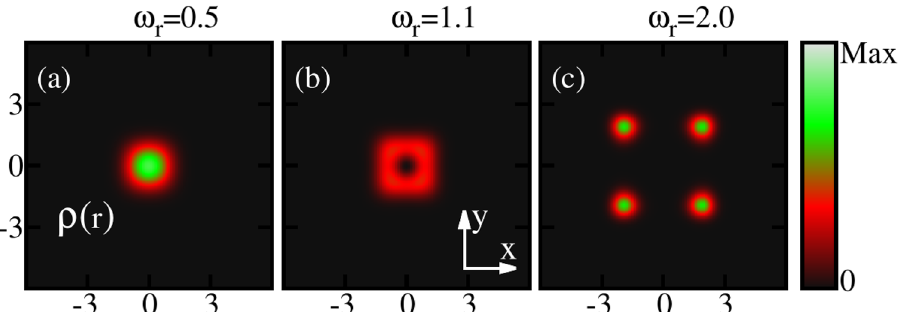
Figure 10. The one-body densities per particle are shown for three different rotation frequencies ω r in the four-fold symmetric trap at the many-body level. M=4 self-consistent orbitals are used. The density computed at the mean-field (not shown) and many-body levels display identical features at all ω r . All quantities shown are